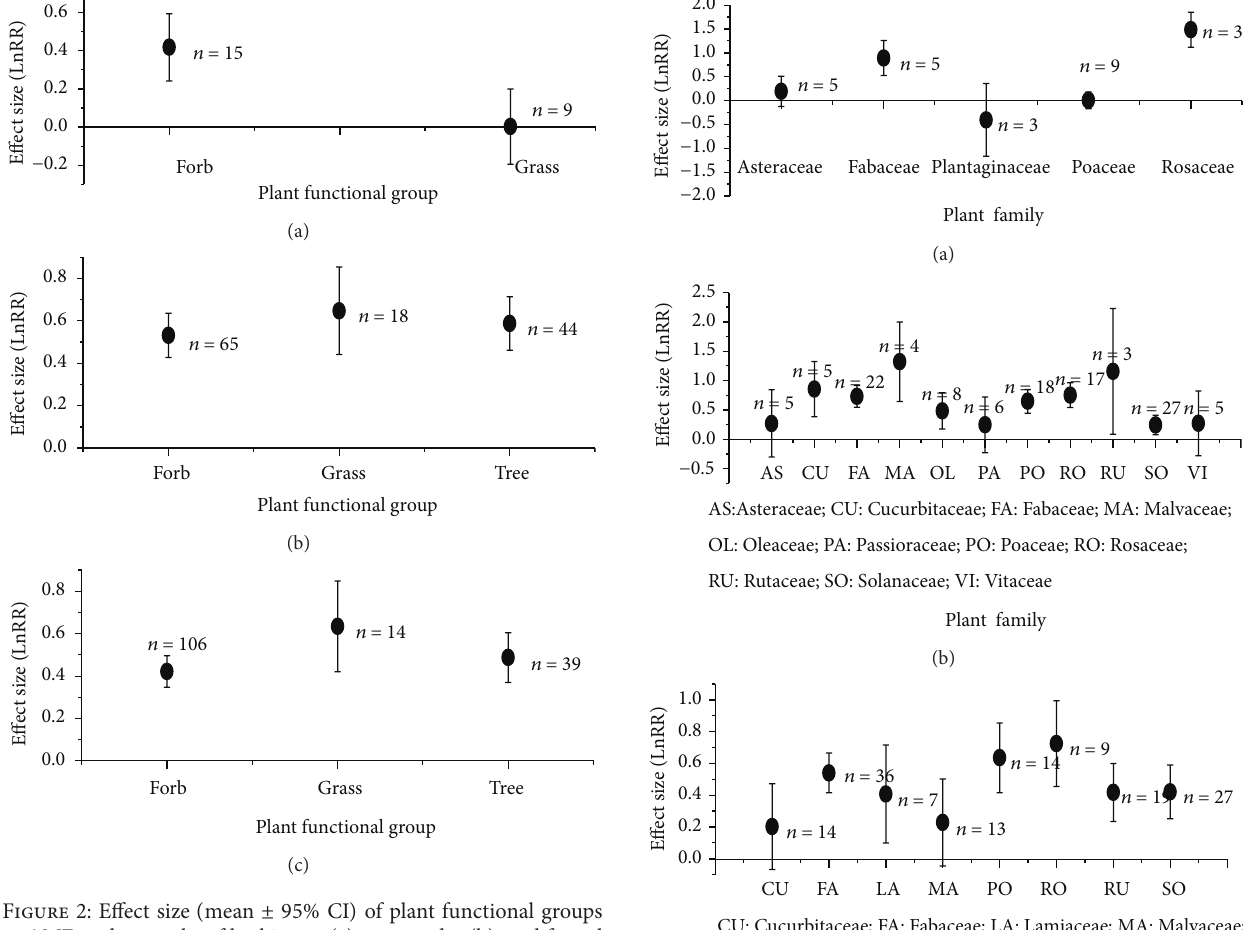
than in wilt-type (effect size with 95% CIs: −0.87 with −0.95∼ − 0.78; −0.59 with −0.68 ∼ − 0.50) (Figure 4(c)). Nonethe-